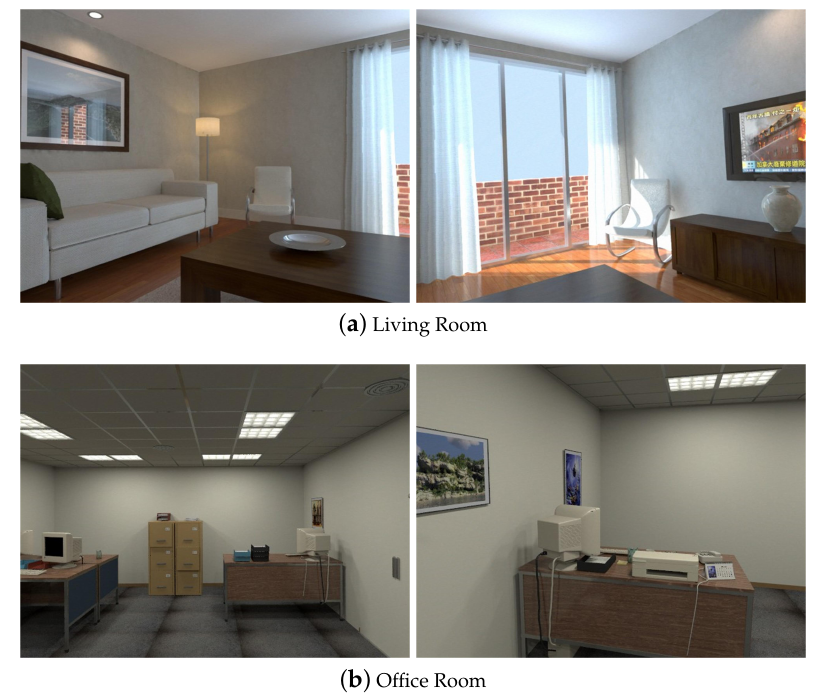
Figure 4. Scenes contained in the ICL-NUIM dataset. ( a ) The living room contains sofa, chairs table and some other common man-made objects. ( b ) The office room contains several tables, computers and pictures.